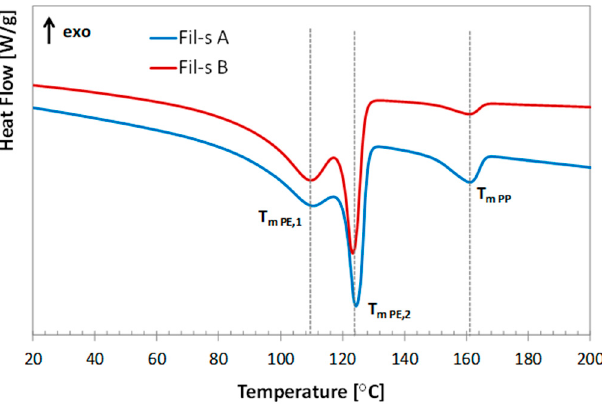
Figure 1. Second heating thermograms for the lots of Fil-s analyzed.